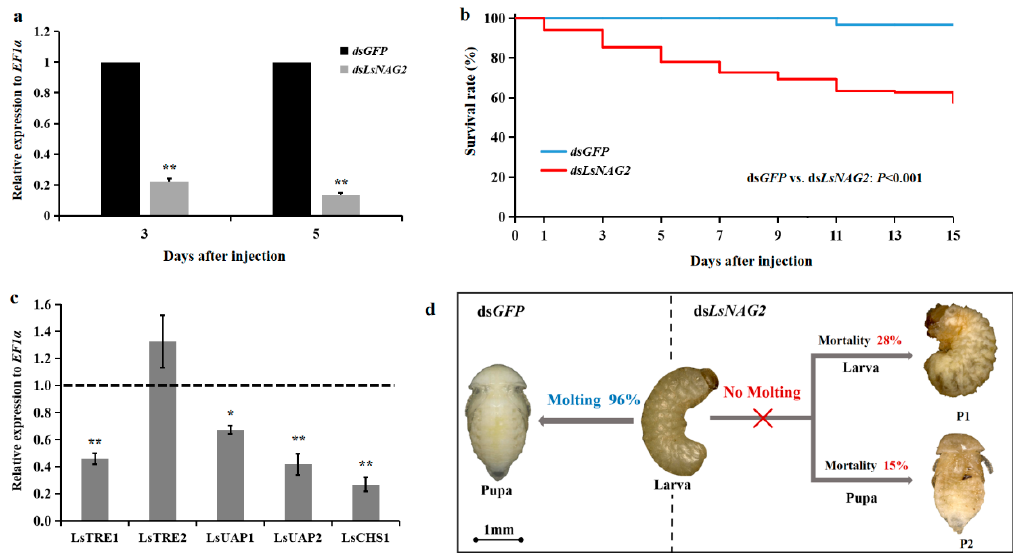
Figure 4. E ff ect of LsNAG2 RNA interference (RNAi) on the larval–pupal transition in L. serricorne . ( a ) Relative expression levels of LsNAG2 at 3 and 5 days after the LsNAG2 or green fluorescent protein ( GFP ) double-stranded RNA injection at day 2 of fifth-instar larvae. ( b ) Changes in survival of L. serricorne larvae after LsNAG2 or GFP dsRNA injection. ( c ) E ff ects of LsNAG2 knockdown on the expression of chitin synthesis pathway genes. The expression level of chitin synthesis pathway genes in the control is marked with a dashed line. ( d ) Representative phenotypes of the larvae after LsNAG2 or GFP dsRNA injection. Injection of ds LsNAG2 resulted in two lethal phenotypes. P1: Larvae were unable to molt, retained the larval form, and ultimately died; P2: insects shed their old cuticles